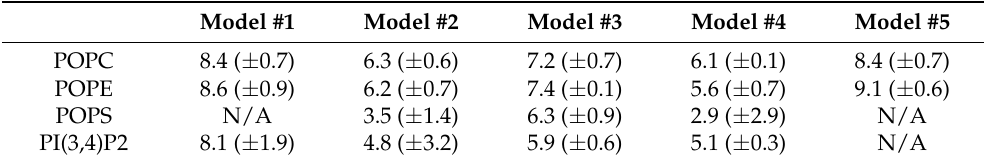
Table 3. Translational diffusion coefficients. An error estimate, which is the difference of the diffusion coefficients obtained from fits over the two halves of the fit interval, is given in parenthesis (). Not applicable